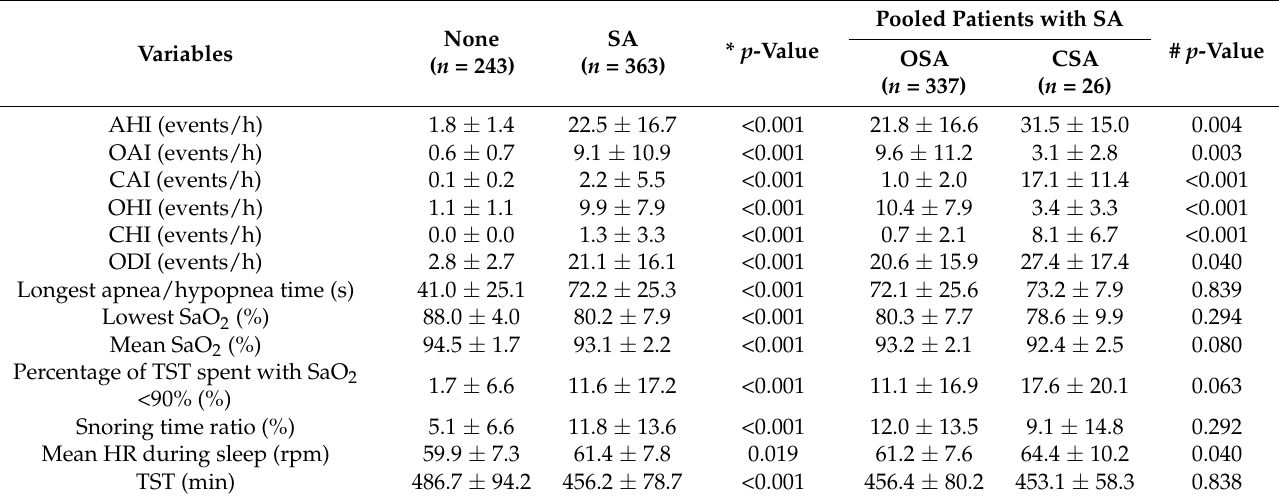
Table 3. Sleep data of patients with HCM grouped according to types of sleep